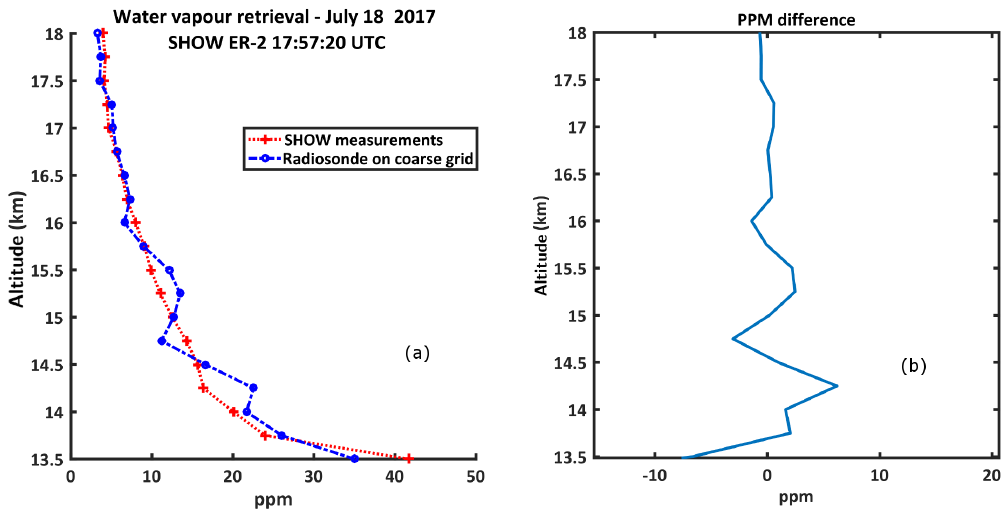
Figure 19. SHOW water vapour retrieval plotted with the radiosonde measurements transformed to the coarse retrieval grid (a) and the ppm difference between the radiosonde and SHOW measurements (b)